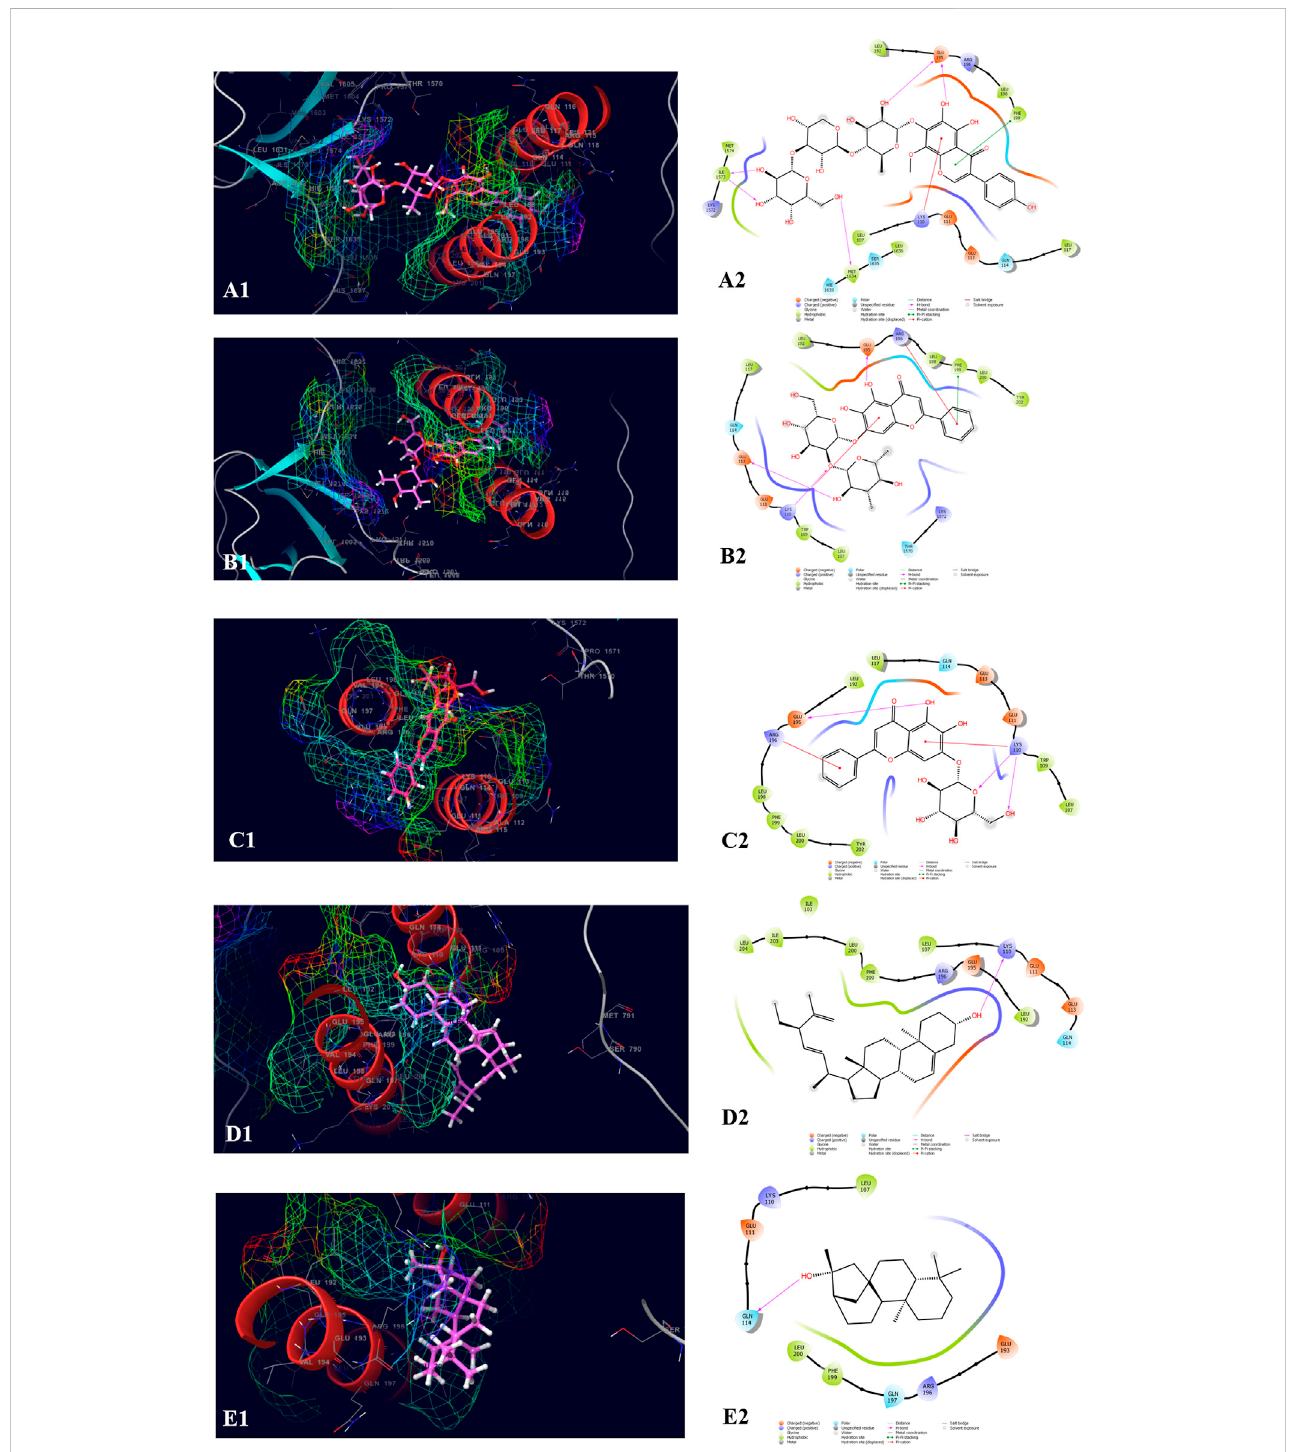
FIGURE 8 Molecular docking interactions of metabolites in the binding pocket of RIMS-binding protein 3A (Gene: RIMBP3) (AlphaFold). [3D and 2D representation of 4 ′ ,5,6,7-Tetrahydroxy-8-methoxyiso fl avone-7-O-beta-D-galactopyranosyl-(1 → 3)-O-beta-D-xylopyranosyl-(1 → 4)- O-alpha-L-rhamnopyranoside (A1,A2) , Baicalein-7-O-diglucoside (B1,B2) , Baicalein-7-O-glucoside (C1,C2) , Stigmasta_5_22_25_trien_3beta_ol (D1,D2) , and Kauran_16_ol (E1,E2) in the binding pocket of RIMS-binding protein 3A (Gene: RIMBP3)